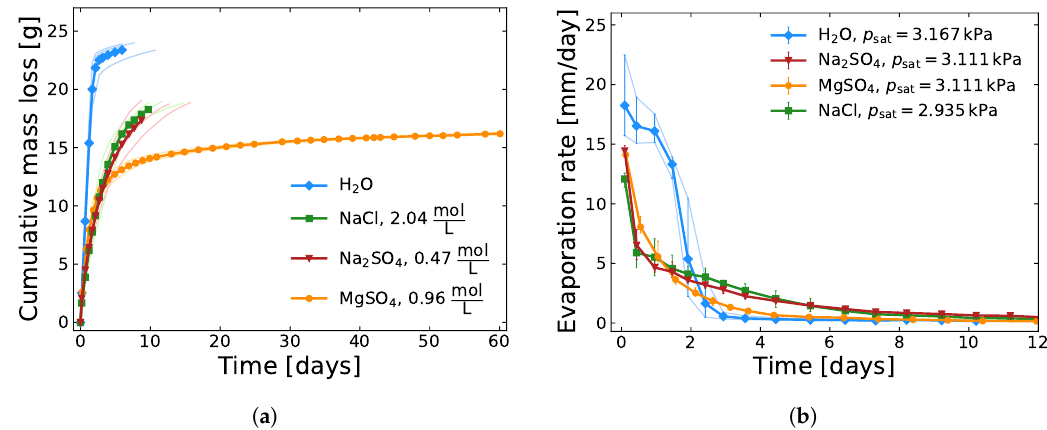
Figure 2. Results of the evaporation experiment. The thin colored lines and the error bars illustrate the variation of the triplicate samples. ( a ) Cumulative mass loss over time. The legend shows the initial concentration of each saline solution (see Table 1). ( b ) Evaporation rate over time. The legend provides the saturation pressure according to the initial concentration (see Table 1). In order to provide a detailed visualization of the evaporation rate at the beginning of the experiments, results are shown until day 12 only. Table 3. Normalized ratios of the initial evaporation rates from Figure 2 and the vapor pressure differences of the initial solutions from Table 1. The ambient vapor pressure p H 2 O determined at 25 ◦ C and 30% relative humidity. According to Equation (1), this ambient vapor pressure was subtracted from the saturation vapor pressure of the initial solutions (Table 1). The resulting vapor pressure difference for each solution is listed in the third column of this